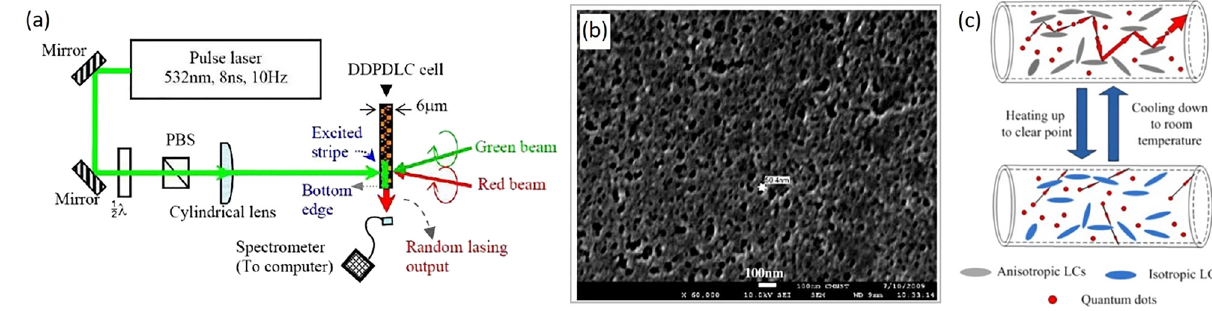
Figure 17: Top view of the experimental setup for examining the all-optically controllable random lasing emission of the DDPDLC cell (6 μ m thick). The green and red beams are circularly polarized ( λ /2, half waveplate for 532 nm; PBS, polarizing beam splitter) (a). The SEM photograph of the DDPDLC cell, in which the length of the white bar is 100 nm, and the black regions are places occupied by nano-sized LC droplets in the polymer matrix (grey regions) [137] (b). Schematic diagram of light propagating in the QD-PDLCs with LCs in the anisotropic phase and the isotropic phase [139]